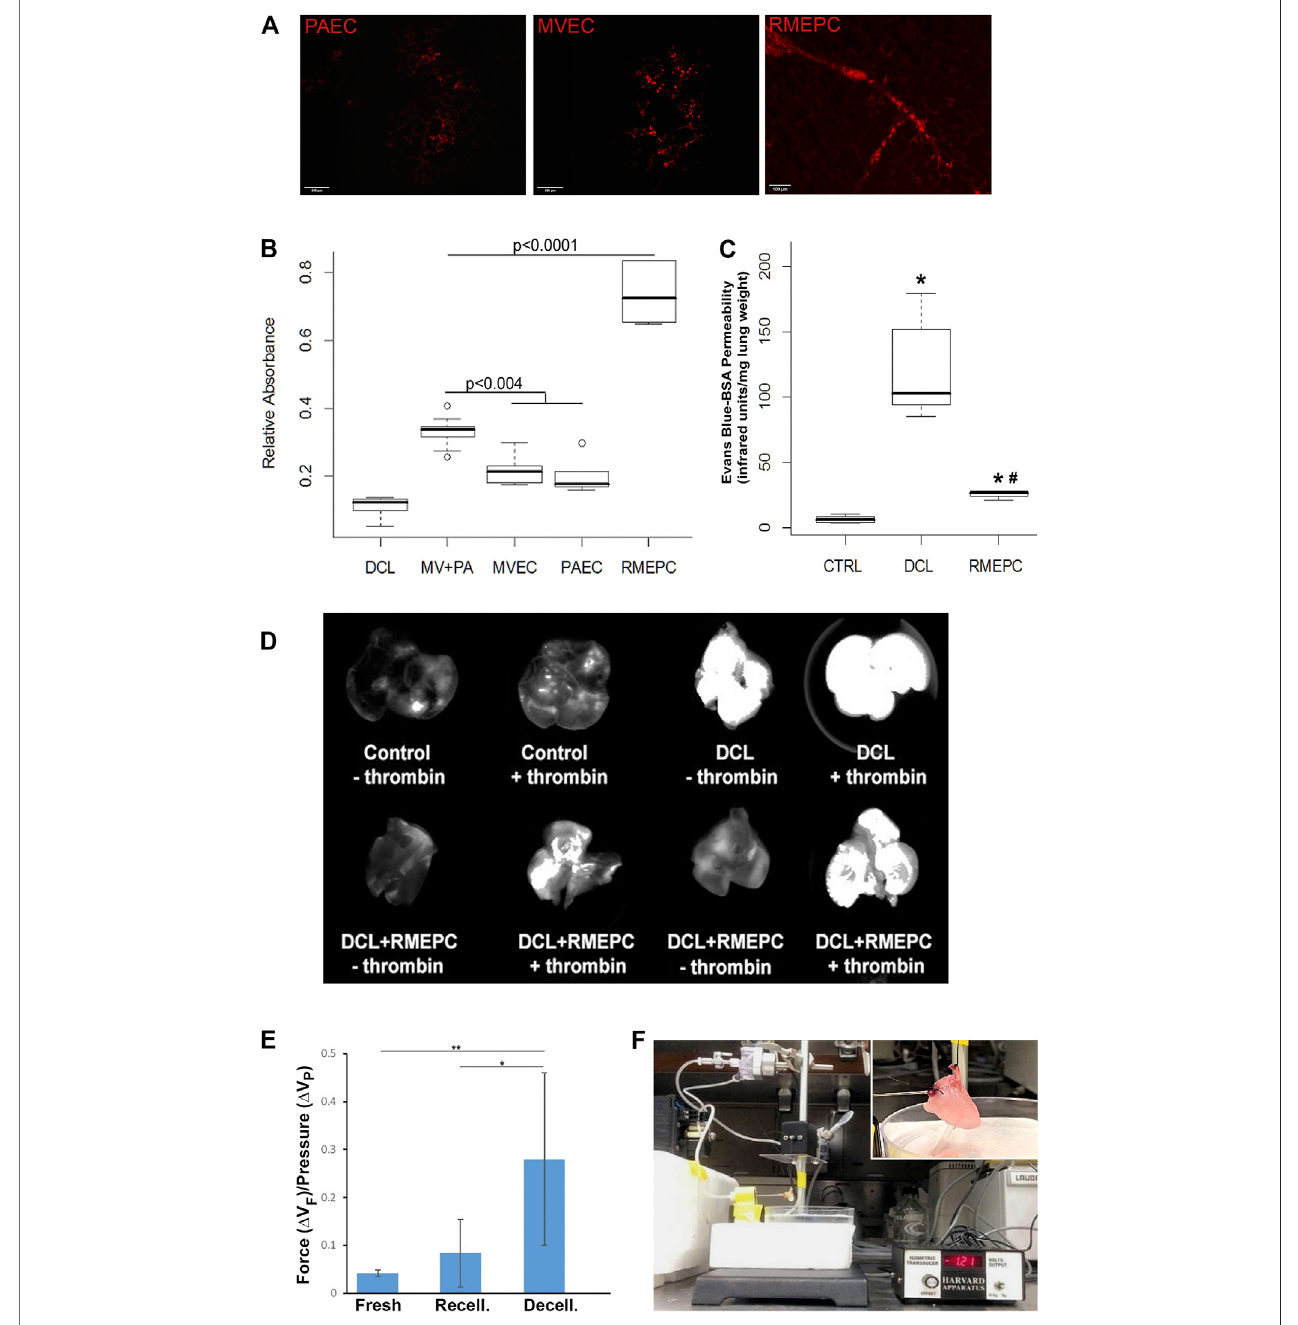
FIGURE 5 | Recellularized lungs are functional and maintain endothelial barrier integrity. (A) Uptake of Dil-Ac LDL in revascularized lungs. Cryosections (5 µm) viewed via confocal microscopy (Left – PAEC, Middle – MVEC, Right – RMEPC). (B) Thrombomodulin activity assay of recellularized lungs after 45 min perfusion with α -thrombinandproteinCcolorimetricactivitywasnormalizedtowholemouselungcontrols( n (cid:2) 6)andcomparedtodecellularizedlungs(DCL, n (cid:2) 6),allothergroups n (cid:2) 3. (C) Vascular permeability of RMEPC-recellularized lungs ( n (cid:2) 4) compared to mouse lung controls (CTRL, n (cid:2) 8) and decellularized lungs (DCL, n (cid:2) 8) measured by near-infrared spectrophotometry of perfused Evans-blue-tagged albumin (EB-BSA). * p < 0.0000004 vs. control; * # p < 0.0004 vs. decellularized lungs. (D) Representative whole lung near-infrared spectrophotometry of EB-BSA showing barrier integrity of RMEPC-recellularized lungs and increased permeability in response to thrombin (+). (E) Comparison of the average change in force ( Δ V F ) gained per increase in pressure ( Δ V P ) for native-fresh ( n (cid:2) 4), decellularized ( n (cid:2) 7), and RMEPC- recellularized( n (cid:2) 6)mouselungs(*indicatesa p -value < 0.05;**indicatesa p -value < 0.001). (F) Setupofisogravimetricexperimentandinsertofaclose-upofheart/lung en bloc .